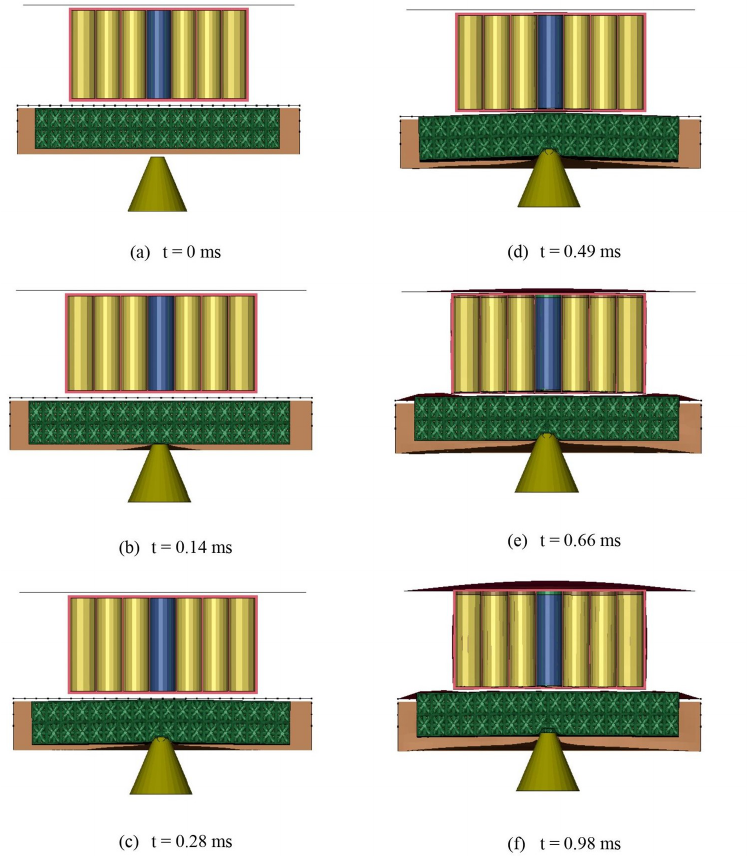
Figure 18. Battery Protection System Response to Ground